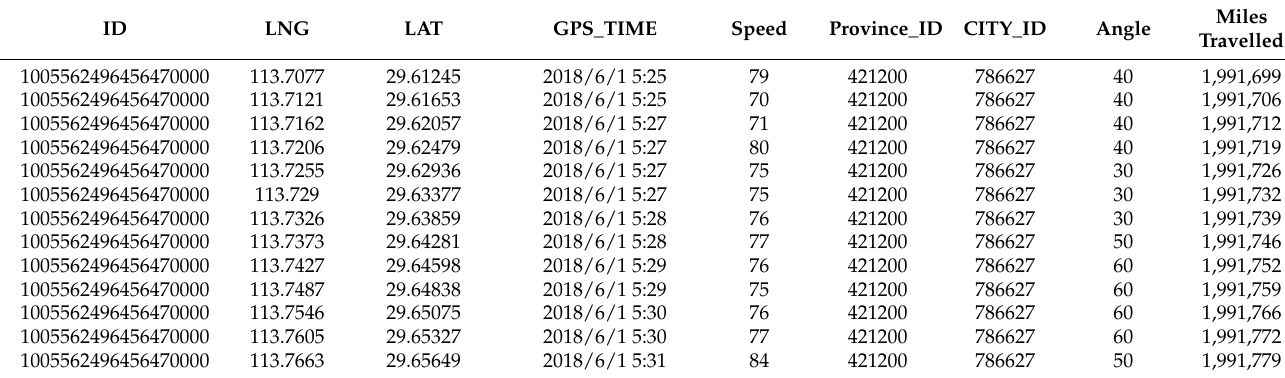
Table 2. Example of truck trajectory data